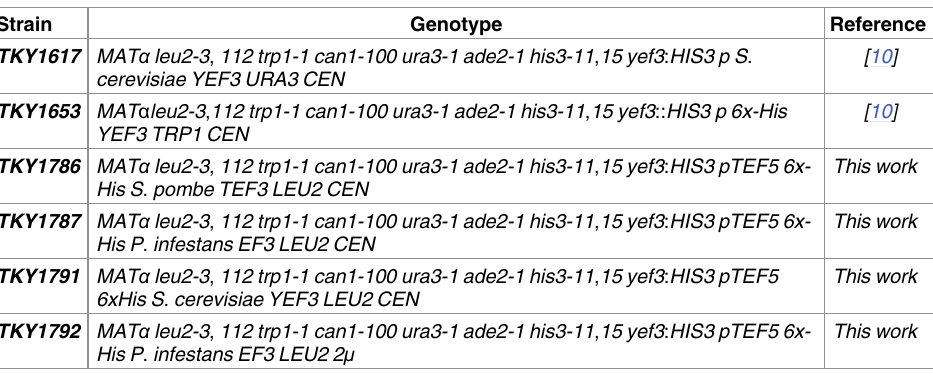
Table 1. S . cerevisiae strains used in this